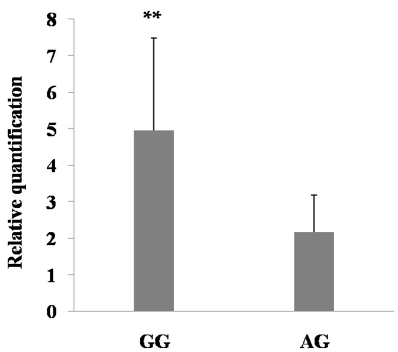
Figure 5. mRNA expression of c.-1376 G>A among the different genotypes in the mammary gland of lactating Holstein cows. Bars represent (mean value ± standard error) ( n = 4). ** p < 0.01.